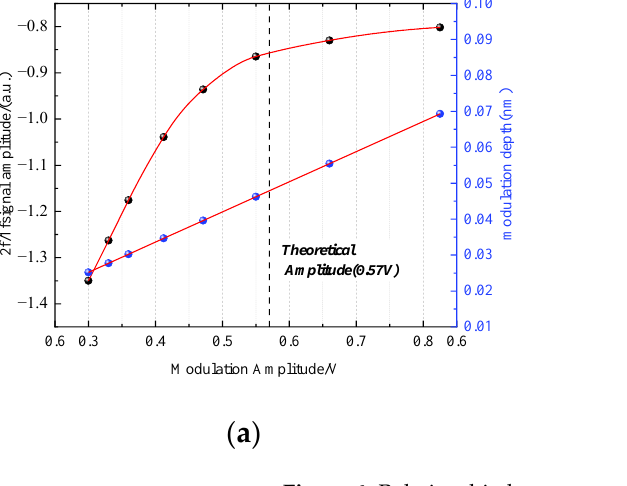
Figure 6. Relationship between modulation amplitude, modulation depth and 2f/1f ( a ) Influence on CH4 detection.; ( b ) Influence on HCl